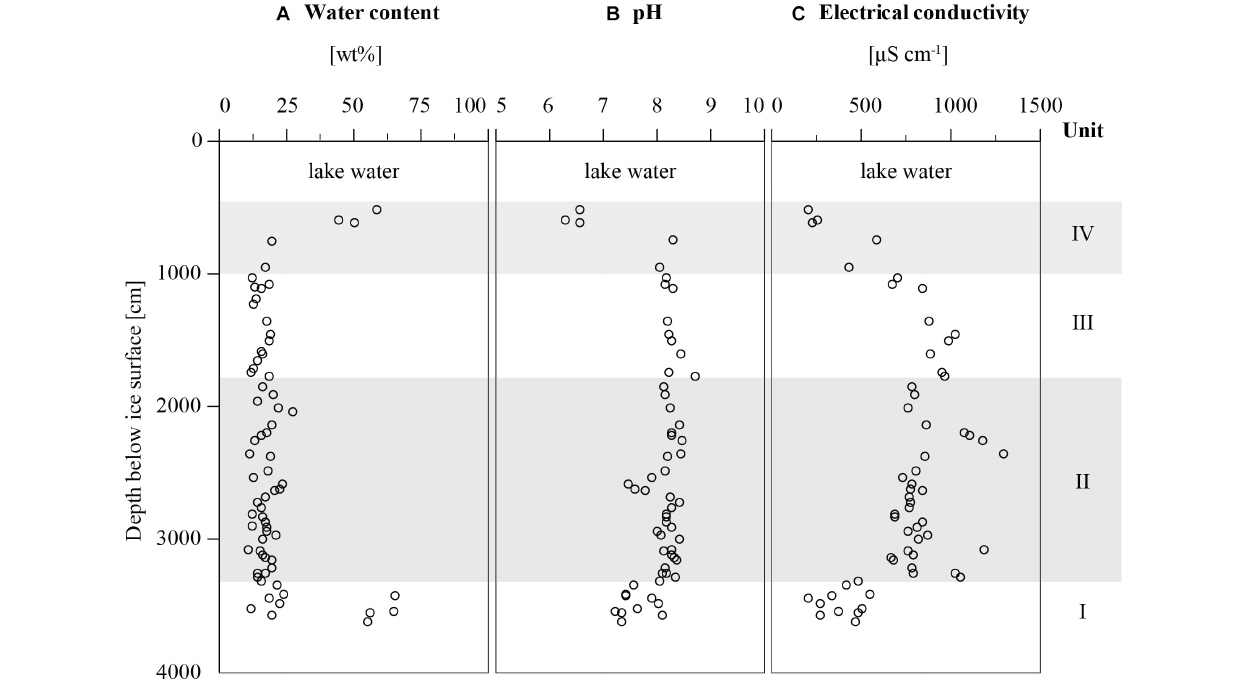
Figure 4C ). In all hydrochemical parameters, the lowermost and uppermost samples of the core were substantially different from the middle